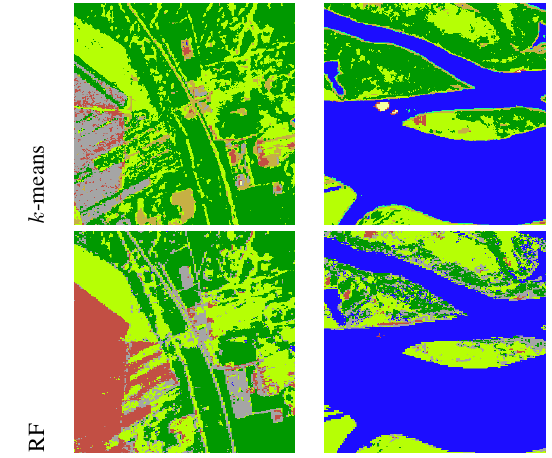
Figure 7. Qualitative results achieved with the shallow classifiers trained on the low-resolution labels of the DFC2020 validation